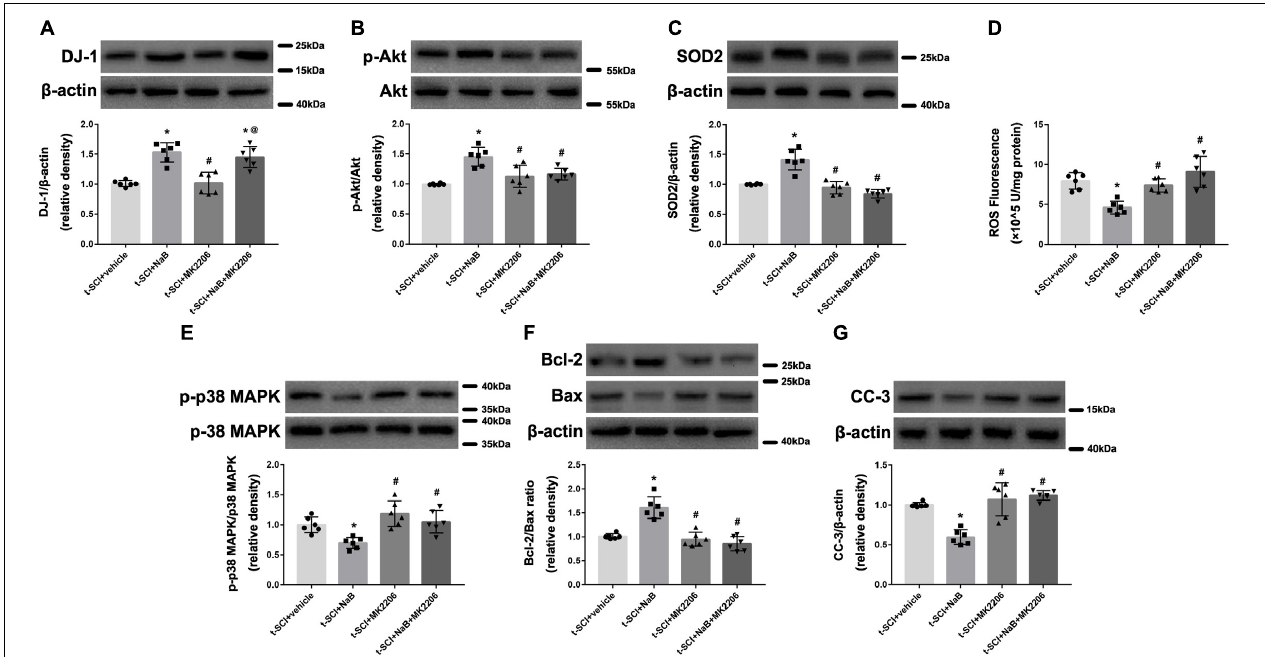
FIGURE 9 | Representative Western blots showing the protein levels in each group at 24 h post-injury. Treatment with NaB significantly increased the level of DJ-1, and this upregulation was not affected by treatment with MK2206 (A) . The increase in the levels of p-Akt and SOD2, induced by NaB, were reversed by MK2206 (B,C) . The decrease in the ROS level, p-p38 MAPK/p38 MAPK ratio, and CC-3 level and the increase in the Bcl-2/Bax ratio, induced by NaB, were reversed by MK2206 (D–G) . Administration of MK2206 alone did not significantly alter the levels of DJ-1, its downstream proteins, and ROS (A–G) . N = 6 for each group. Data is expressed as mean ± SD and analyzed by one-way ANOVA and Bonferroni’s post hoc multiple comparisons test. ∗ p < 0.05 versus t-SCI + vehicle; # p < 0.05 versus t-SCI + NaB; @ p < 0.05 versus t-SCI +